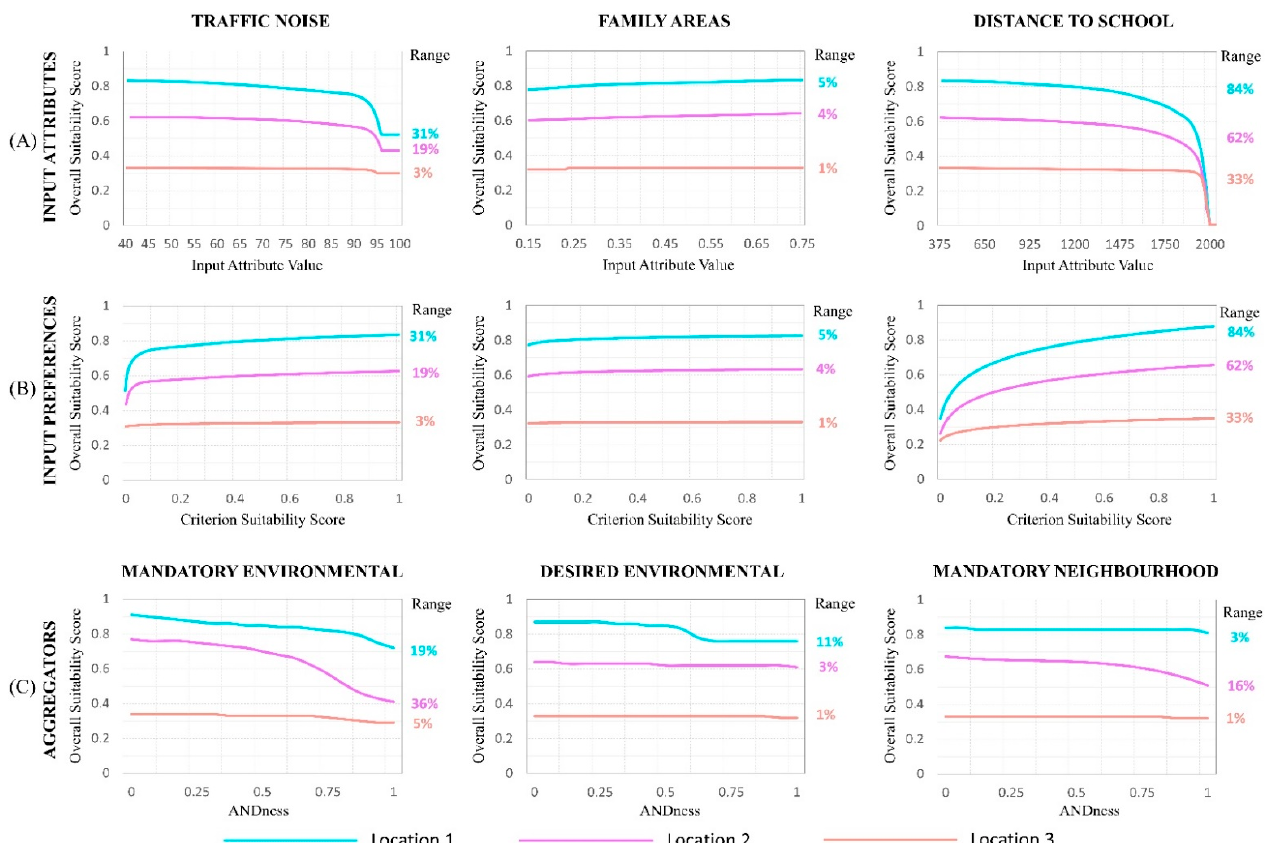
Figure 9. Sensitivity curves obtained for three locations using varying values for ( A ) input elementary attributes and ( B ) input elementary preferences for three elementary criteria and ( C ) aggregators of varying ANDness for three aggregation subgroups.